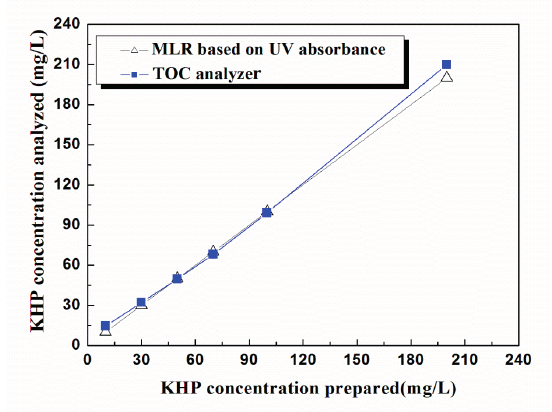
Figure 4. Comparison of KHP concentrations calculated by MLR analysis based on UV absorbance with those measured by a conventional TOC analyzer using the UV-persulfate oxidation method (Multi N/C, Analytik Jena AG, Langewiesen, Germany).